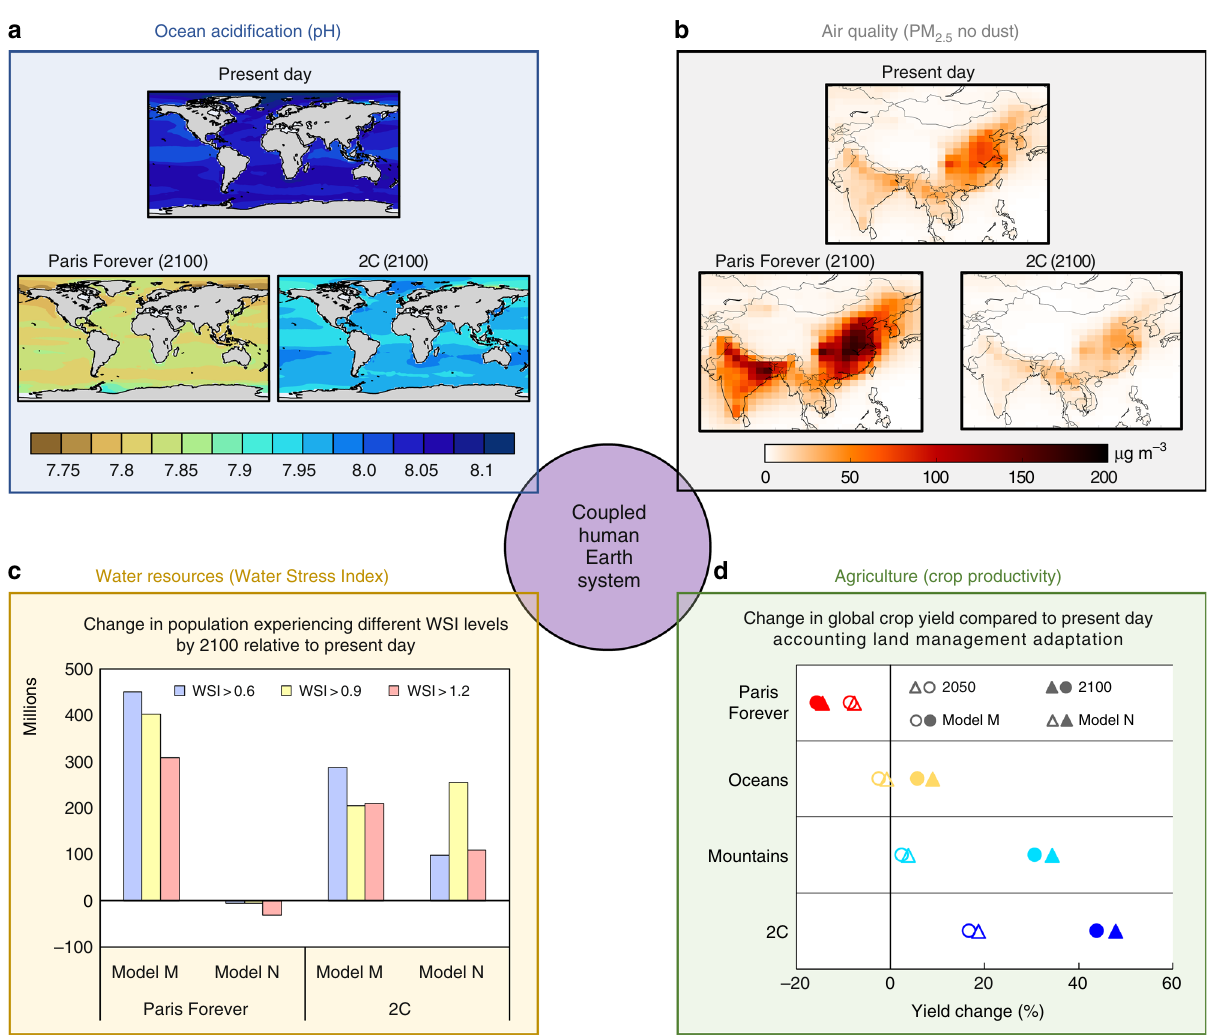
Fig. 3 Sample multi-sectoral climate impact assessment using the improved coupled human-Earth system modeling framework. Climate impacts are focusing on a ocean acidi fi cation (pH), b air quality over China and India (PM 2.5 , no dust), c water resources (Water Stress Index) and d agriculture (crop productivity). Except for the air quality analysis, present day, 2050 and 2100 correspond to, respectively, 10-year averages over the 2001 –